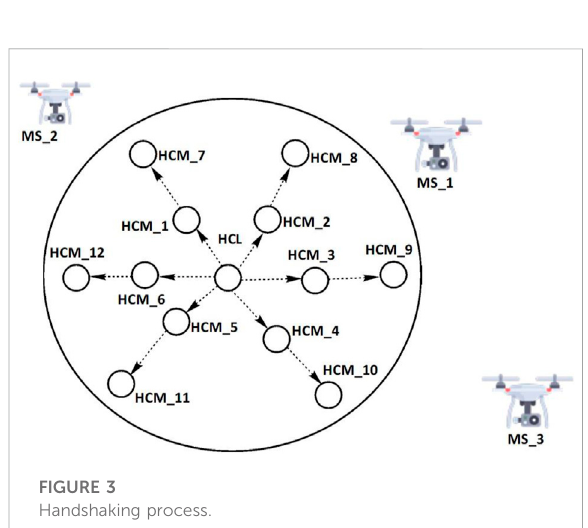
FIGURE 3 Handshaking process.